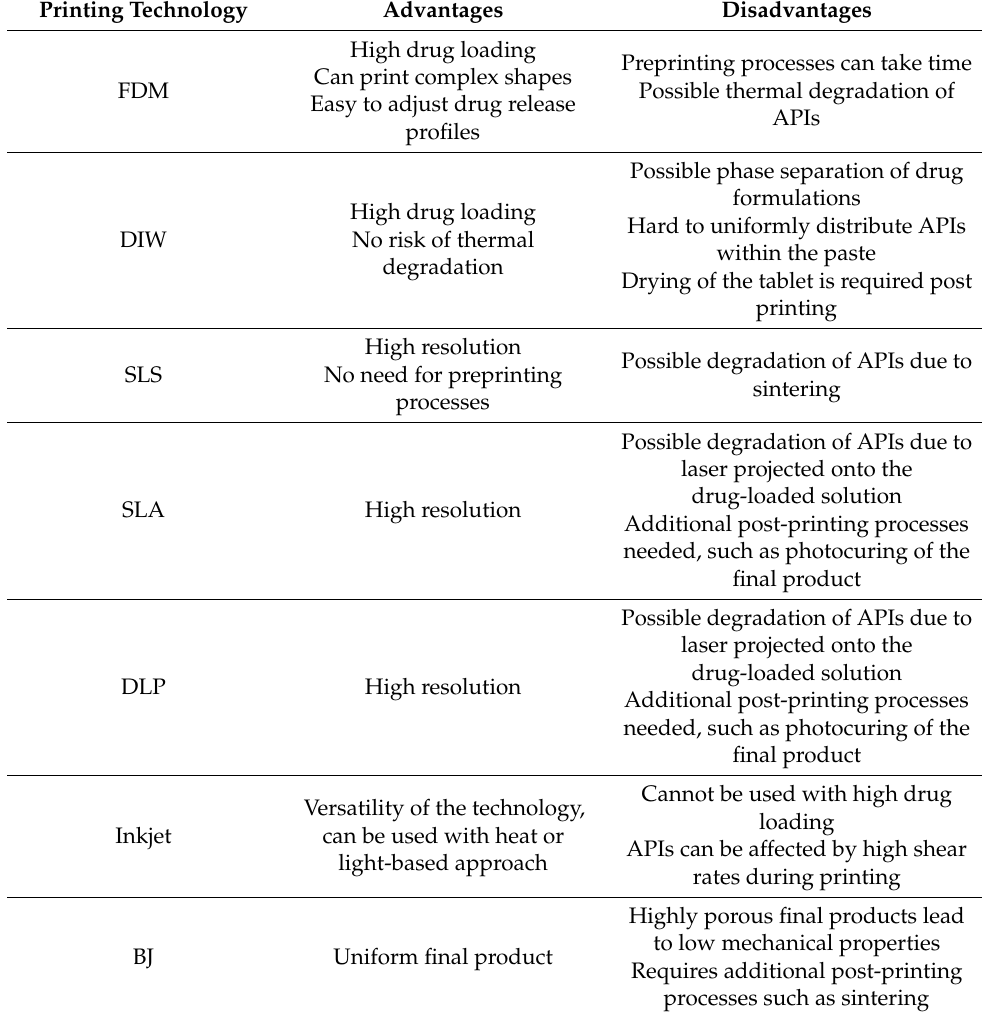
Table 3. Advantages and disadvantages of printing technologies used in tablet printing